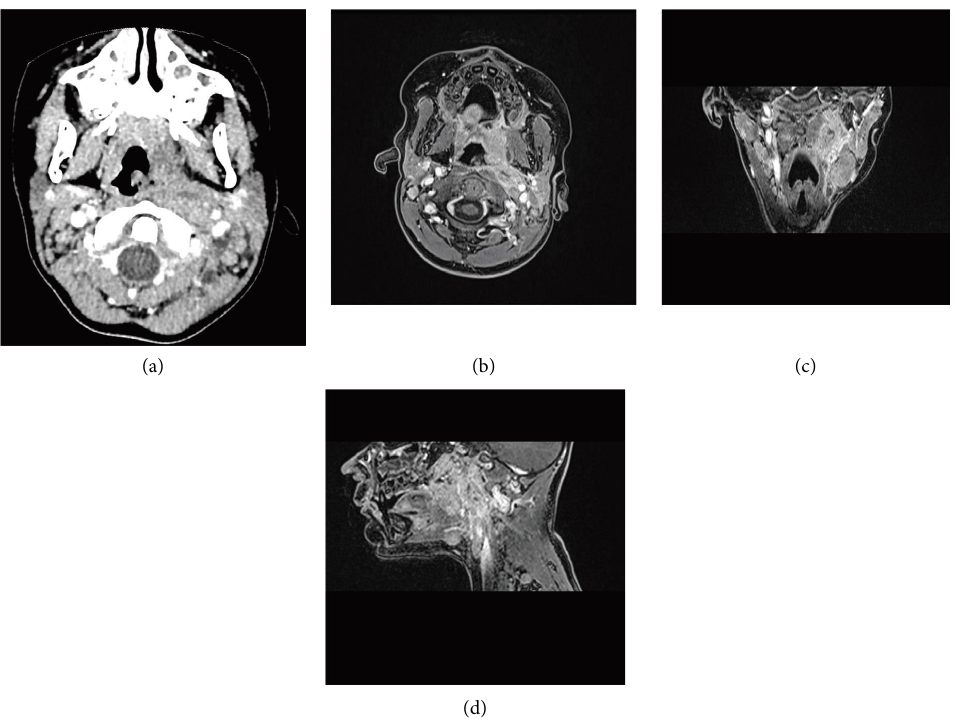
Figure 1: (a) Head and neck CTscan showing retropharyngeal soft tissue swelling and central low-density area, without rim enhancement. (b–d) Head and neck MRI (contrast enhanced T1) showing tissue enhancement with a central hypodense area of left deep parapharyngeal space near carotid space.